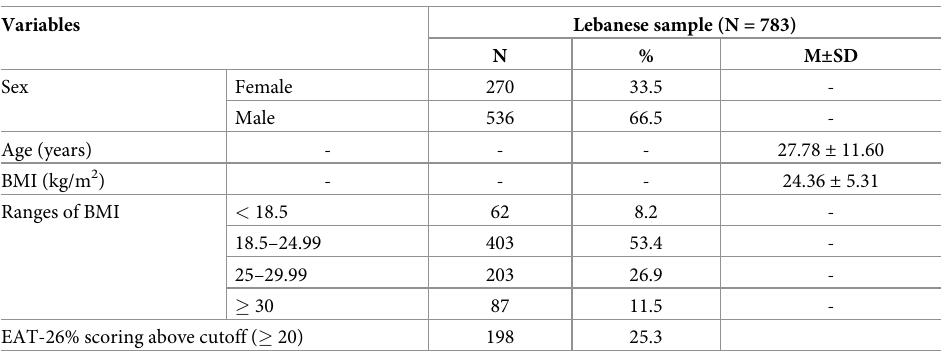
Table 1. Characteristics of